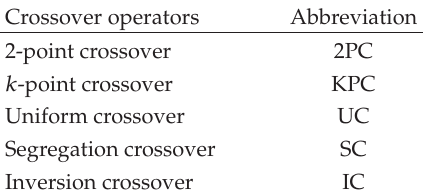
Table 4: Abbreviations of crossover operators.